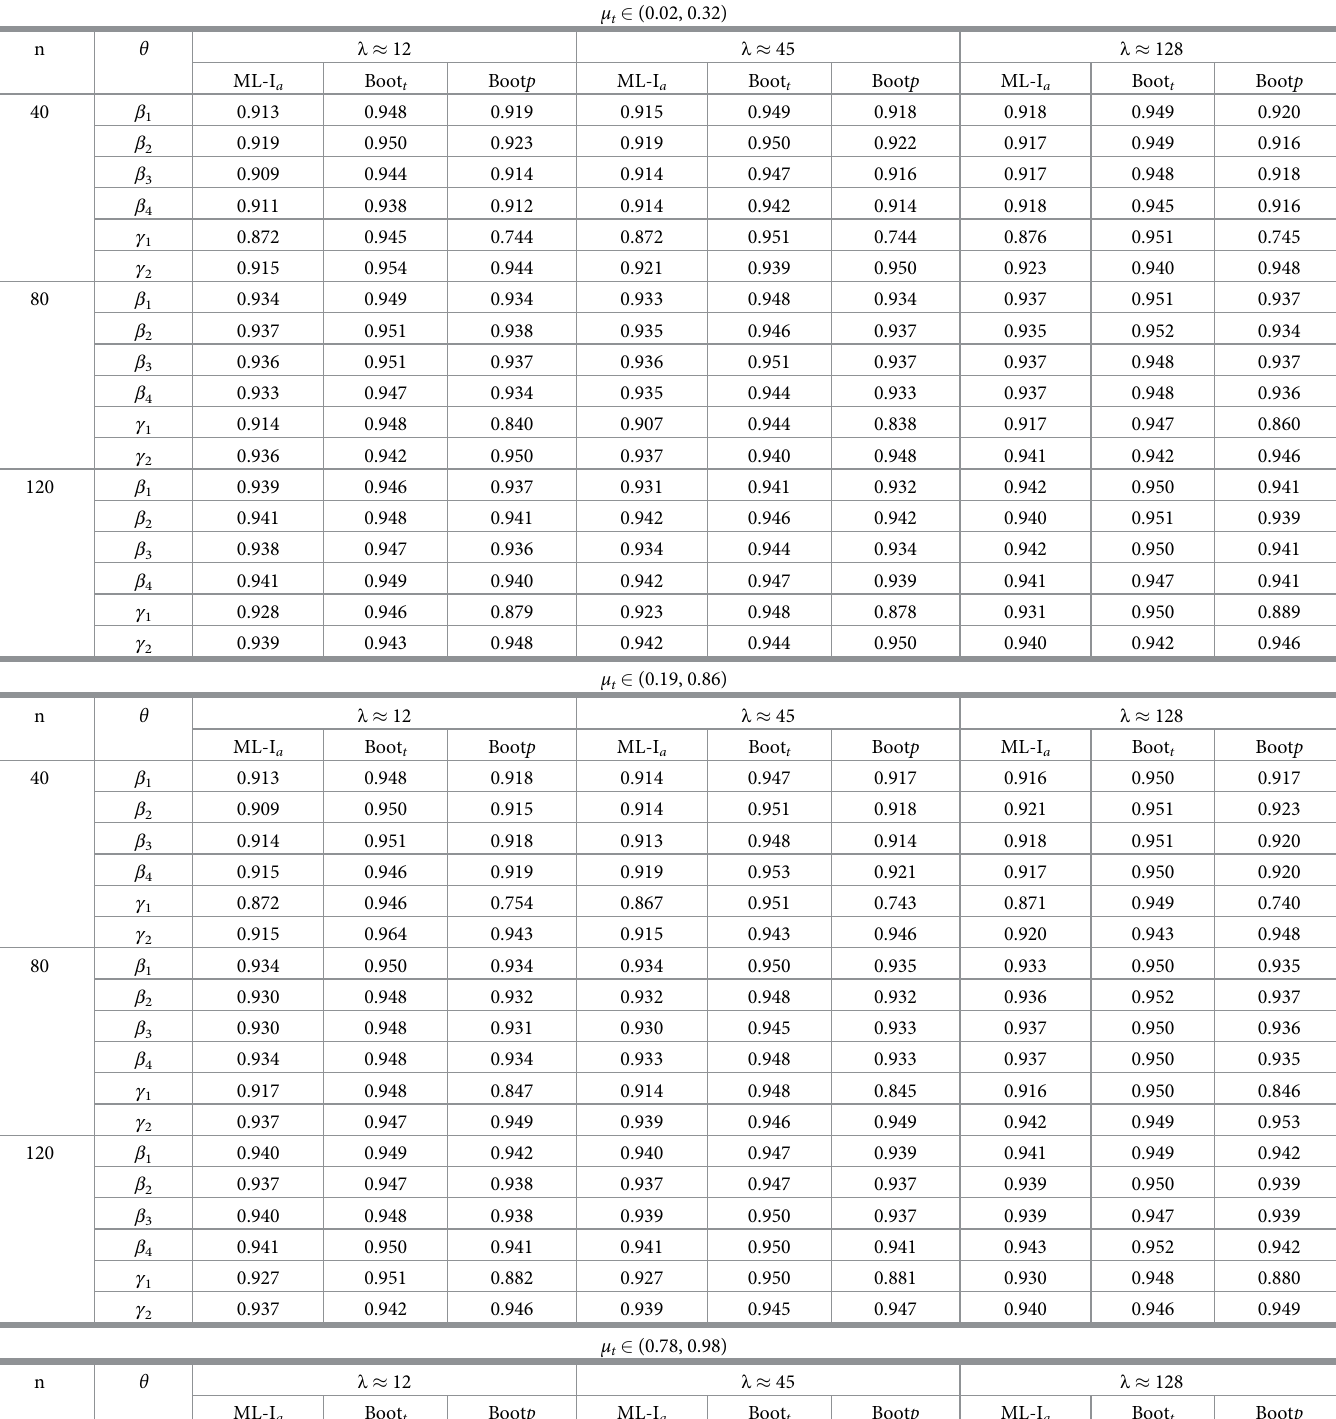
Table 5. Coverage rates of the interval estimators: ML-I log ð σ